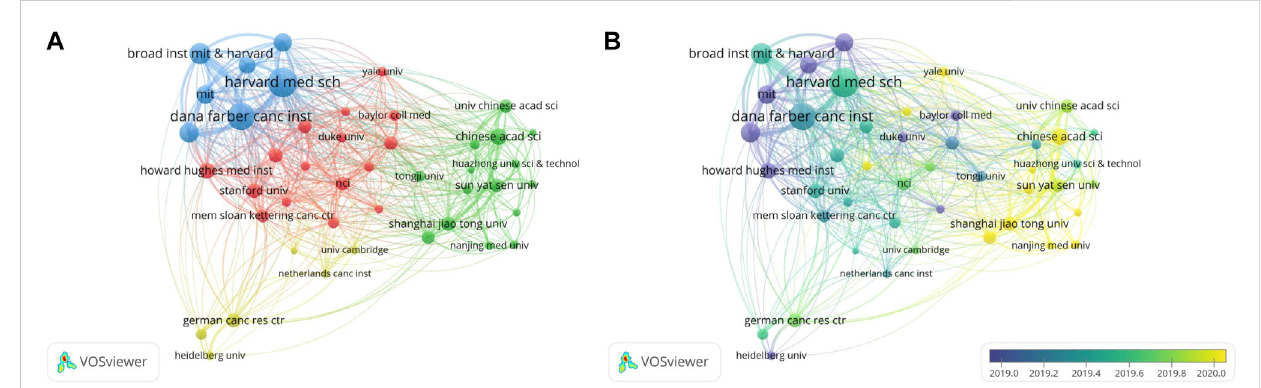
FIGURE 5 Co-authorship analysis of leading organizations on CRISPR in cancer. (A) Network visualization map of the leading organizations collaboration. (B) Overlay visualization map of the leading organizations collaboration.